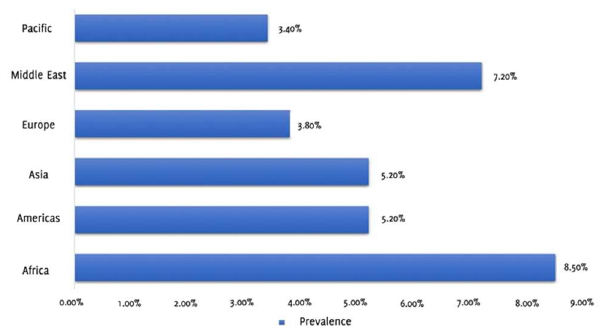
Figure 2 . Regional prevalence estimates of G6PD deficiency (Data collected from: Nkhoma E, Poole C, Vannappagari V, Hall S, Beutler E. The global prevalence of glucose-6-phosphate dehydrogenase deficiency: A systematic review and meta-analysis. Blood Cells Mol Dis. May-Jun 2009;42(3):267-78). 8